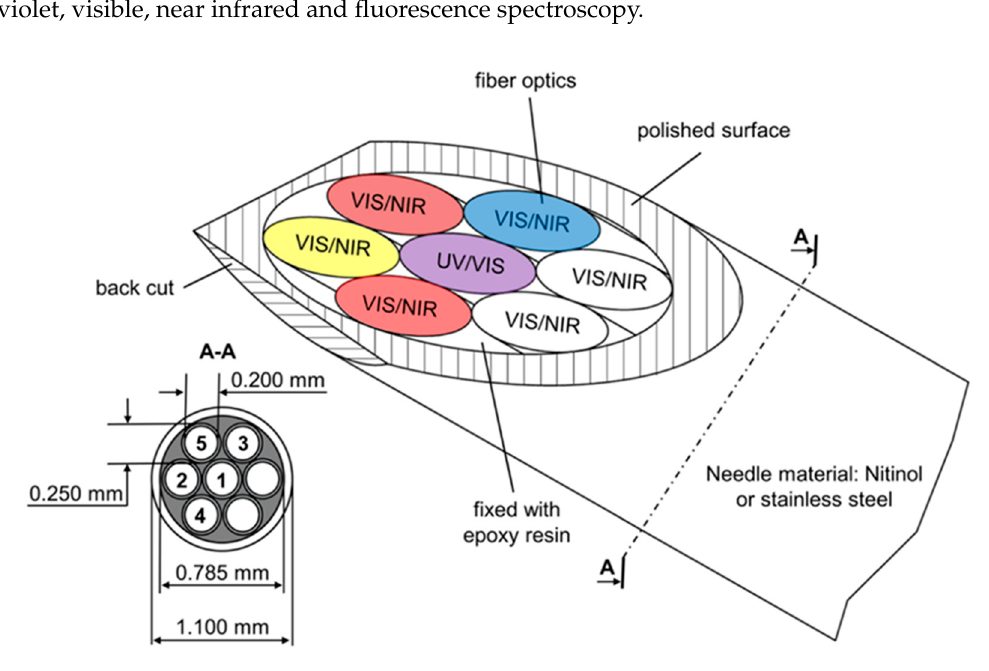
Figure 13. Needle probe for multispectral backscattering measurements. Ultraviolet (UV), visible (VIS), NIR, and fluorescence measurements are possible. The needle is optimized for tissue penetration with a front and back cut [13].